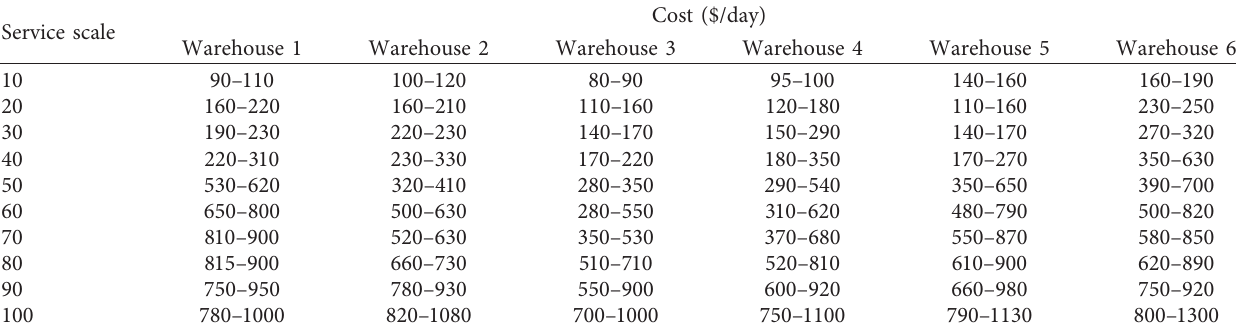
Table 2: Gradient warehouse capacity and service scale.